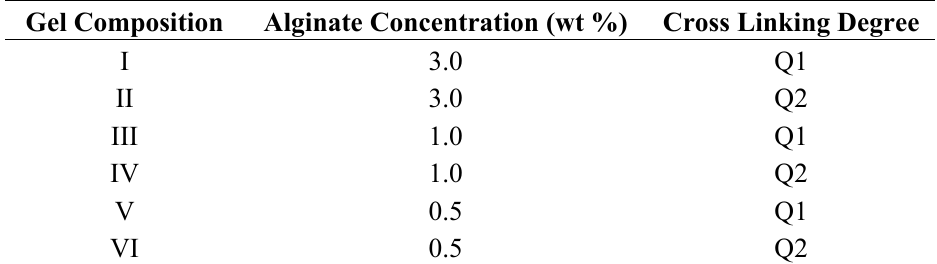
Table 3. Compositions of the gels used throughout the